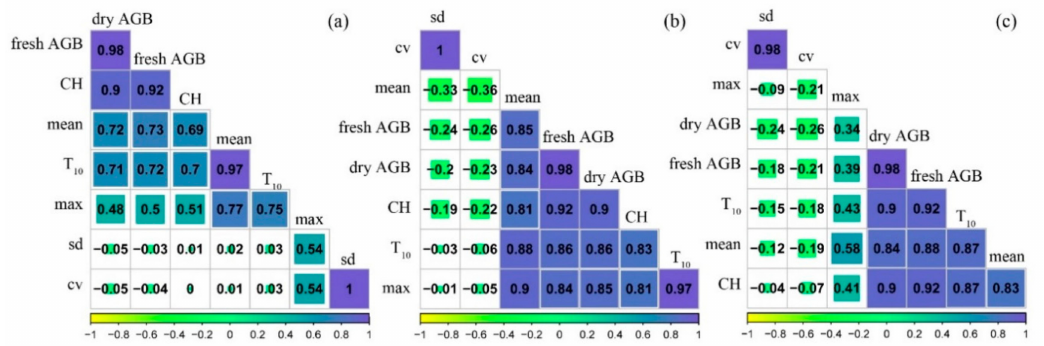
Figure 7. Pearson correlation coe ffi cient ( r value) between the 3D statistical variables from ( a ) the multiSPEC-4C, ( b ) the Micasense RedEdge-M, and ( c ) the LiDAR point clouds and the ground-measured fresh AGB / dry AGB / Crop height